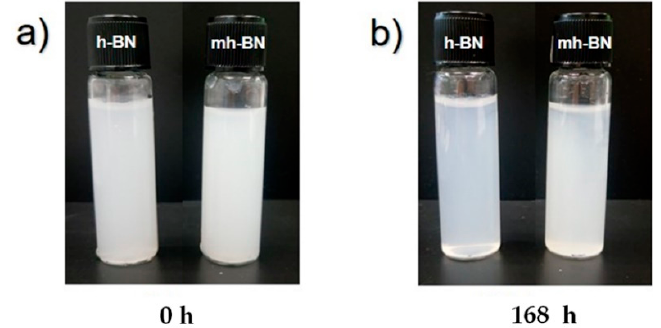
Figure 1. Dispersions of unmodified (h-BN) and plasma-modified (mh-BN) nanoparticles in water: ( a ) initially and ( b ) after 168 h standing.